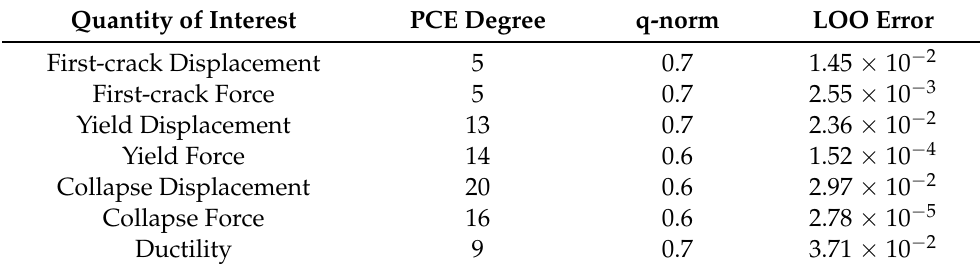
Table 2. Degree, q-norm and LOO error of PCE